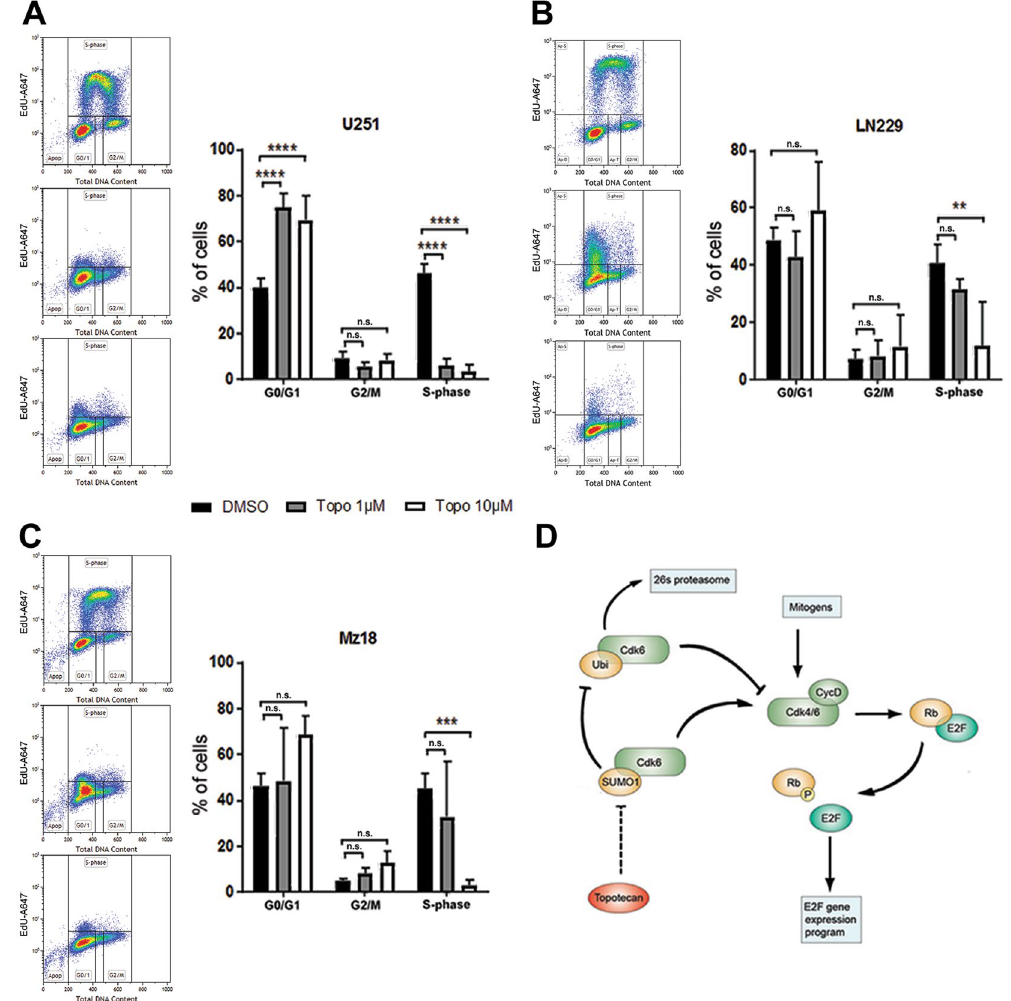
Figure 5. Topotecan alters the cell cycle in GBM lines effecting a decrease in S-phase progression in U251 ( A ), LN229 ( B ), and Mz18 ( C ) and an increase in G0/G1-phase restriction in U251 ( A ). FACS was used to determine the phase of the cell cycle via the incorporation of 5-ethynyl-2 ′ -deoxyuridine (EdU). Data are means ( ± SD) from n = 3 independent experiments. ** p ≤ 0.01, *** p ≤ 0.001, **** p ≤ 0.0001 vs . DMSO. ( D ) Putative mechanism by which topotecan perturbs the CDK6 axis and cell cycle progression at the 1 μ M and 10 μ M